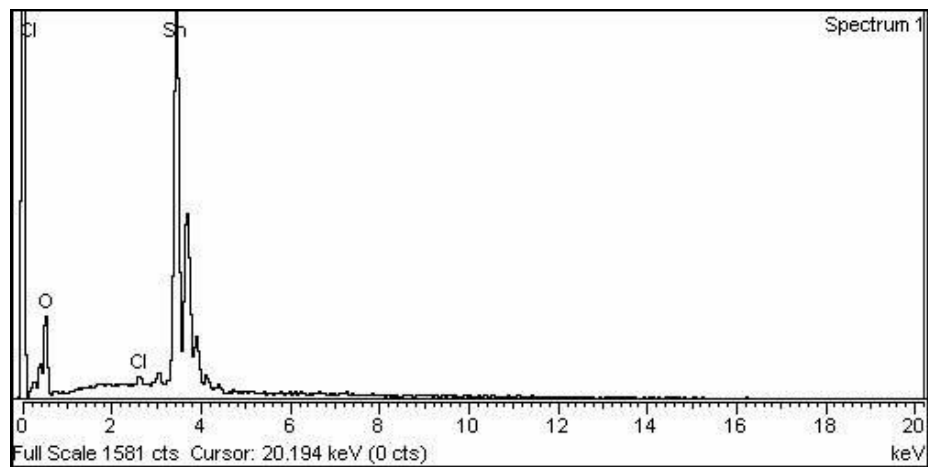
Figure 2. EDX pattern of SnO 2 NPs.